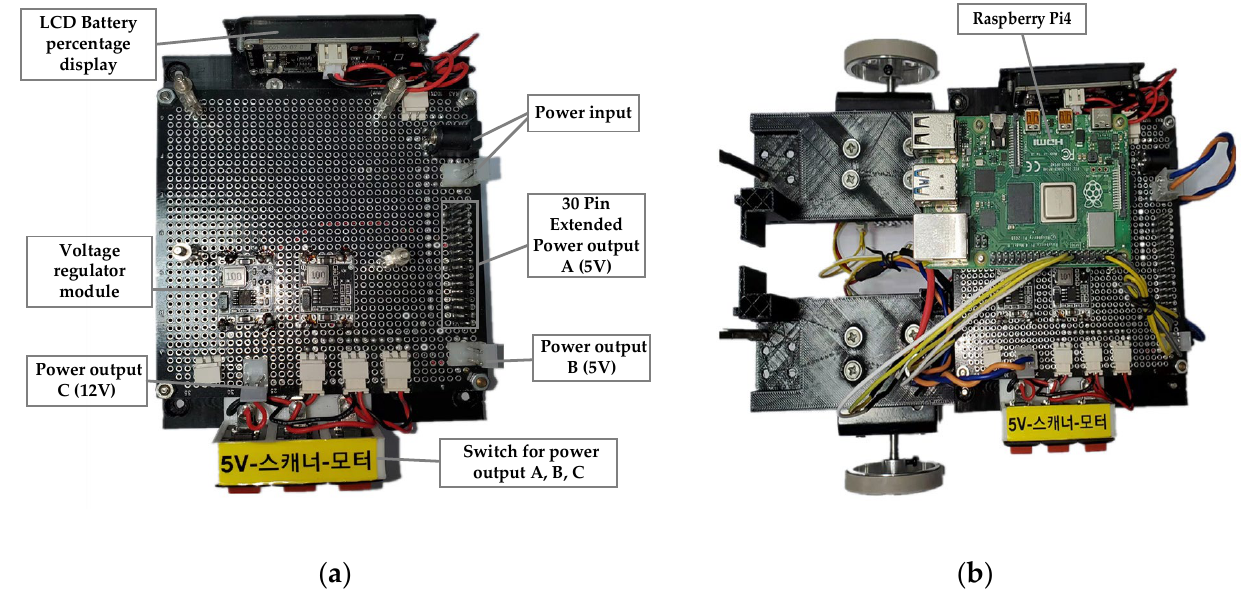
Figure 3. First layer of Owlbot. ( a ) Power management board; ( b ) Installation diagram. Table 2. Owlbot components.